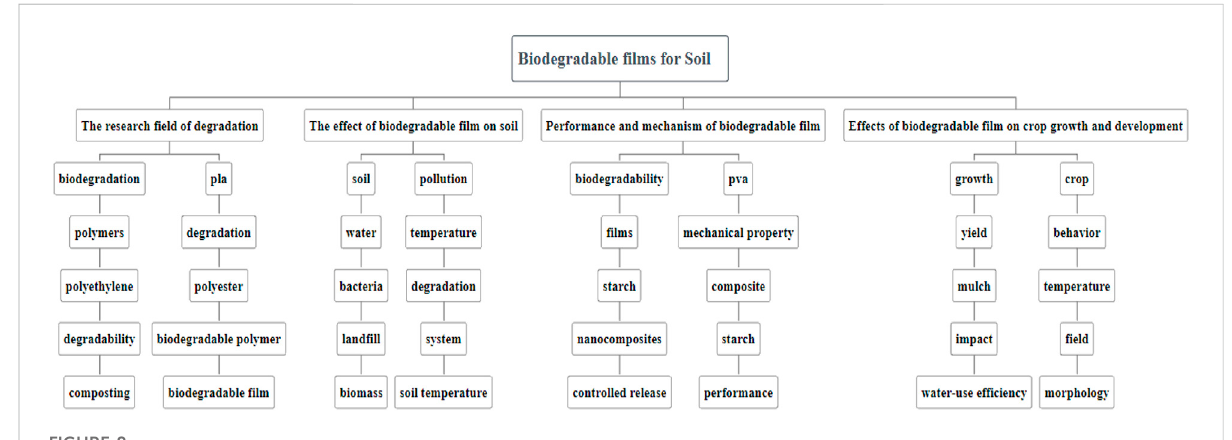
FIGURE 8 A map of knowledge structures for biodegradable fi lm for